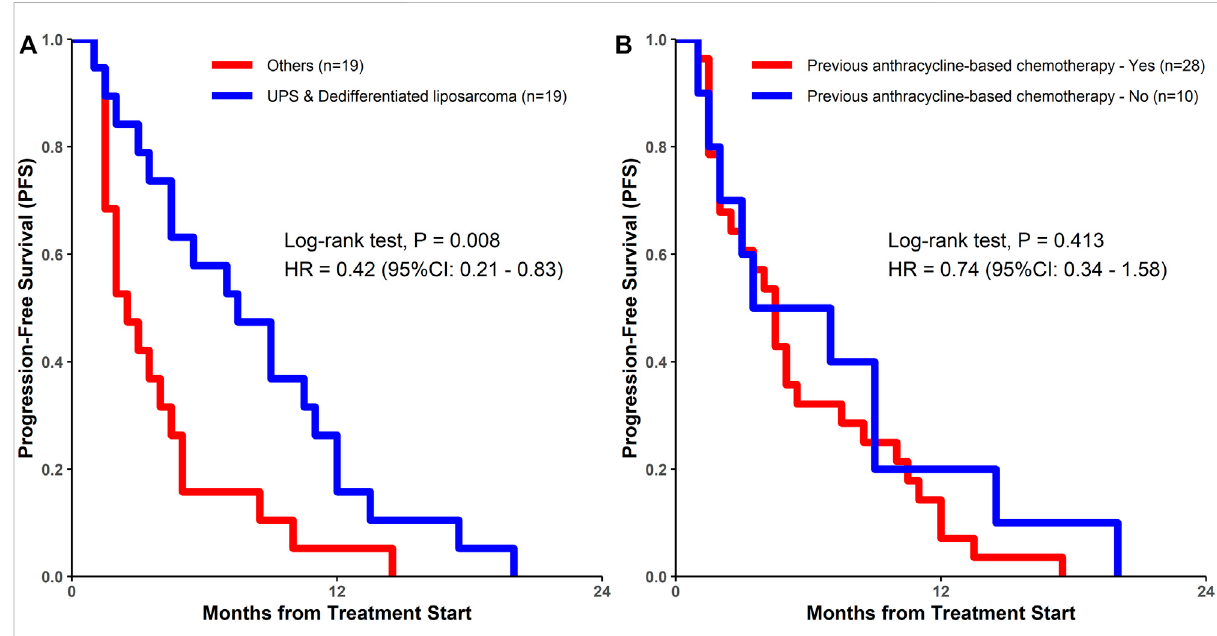
FIGURE 4 Kaplan-Meier estimates of progression-free survival among (A) patients with UPS and dedifferentiated liposarcoma vs. patients with other sarcomas; (B) patients who had previously undergone doxorubicin-based chemotherapy vs. those who had not undergone doxorubicin-based chemotherapy. UPS, undifferentiated pleomorphic sarcoma; DOX, doxorubicin; HR, hazard